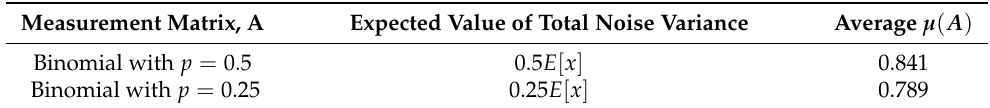
Table 2. Total noise variance and mutual coherence for A with the given properties of a binomial distribution.